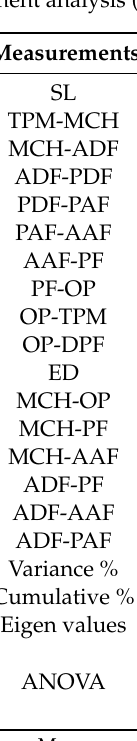
Measurement abbreviations explained in Figure 1. Table8. Componentloadings, percentofvariance(%V),Eigenvaluesandtwo-wayANOVAsignificance for the principal component analysis (with varimax